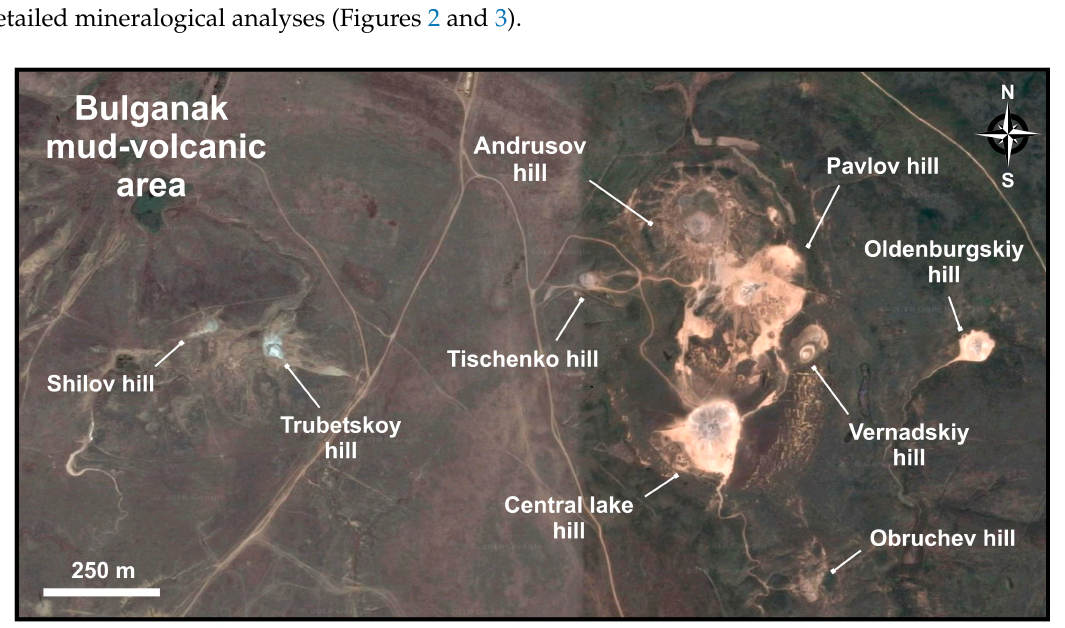
Figure 2. Study area. Panoramic view of the Bulganak field of mud volcanism. Google Earth image, 2007.